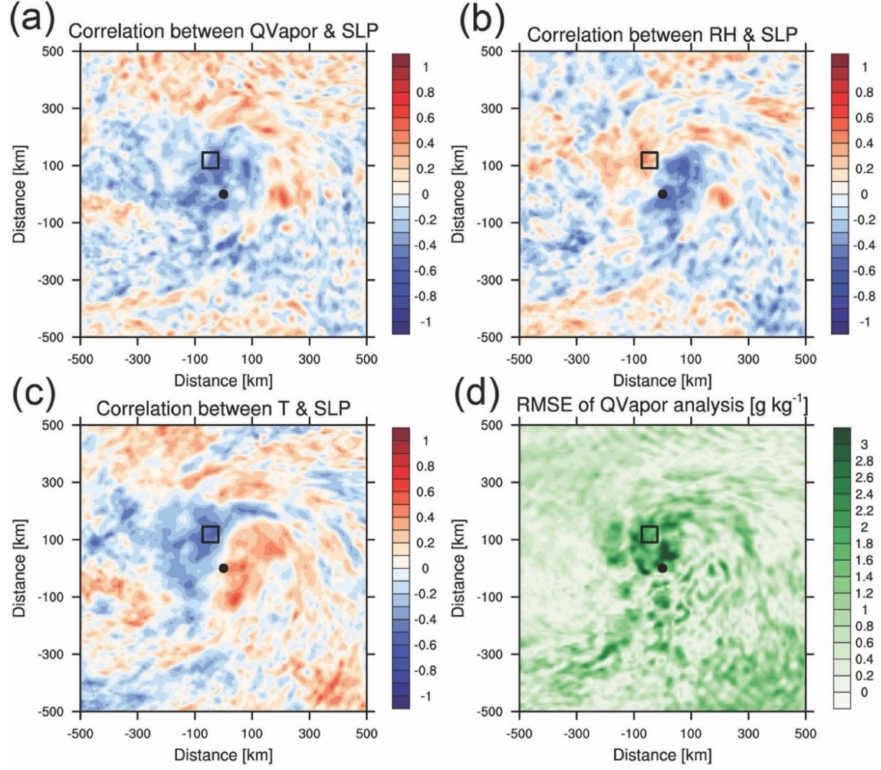
Figure 14. Correlation between surface pressure background ensemble forecast at the TC center and ( a ) mixing ratio, ( b ) relative humidity, and ( c ) temperature background ensemble forecasts, and ( d ) the RMSE of analysis ensemble mean mixing ratio valid at 1800 UTC 3 November. The black dot denotes the TC center, and the black box indicates the location where the analysis and background ensemble are sampled for Figures